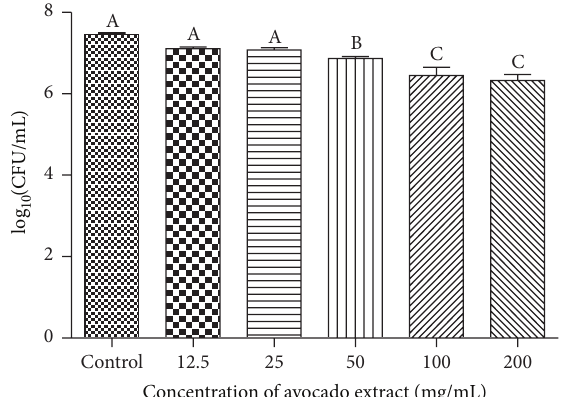
Figure 1: Number of CFU/mL (log 10 ) obtained in the untreated group (control 0.9% NaCl) and treated group with different con- centrations of the extract for 5min ( 𝑛 = 10 ). ANOVA and Tukey test ( 𝑃 < 0.05 ). Different letters indicate statistically significant differences.